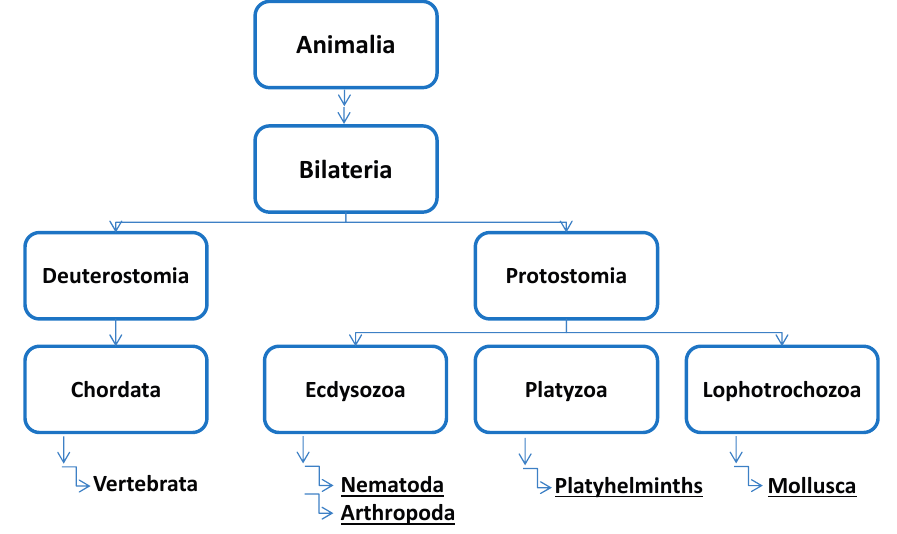
Figure 1. Evolution tree of the kingdom of Animalia (condensed). Only those phyla where at least some information about O- glycans is available are given. Underlined phyla are topic